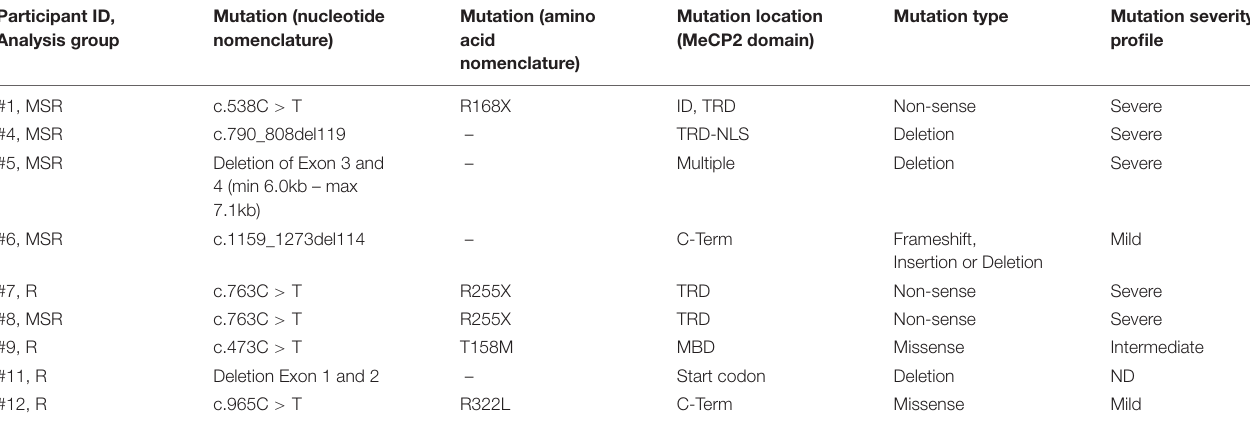
TABLE 2 | Methyl-CpG binding protein 2 ( MECP2 ) mutation profiles of participants with classic RTT. Participant ID, Analysis